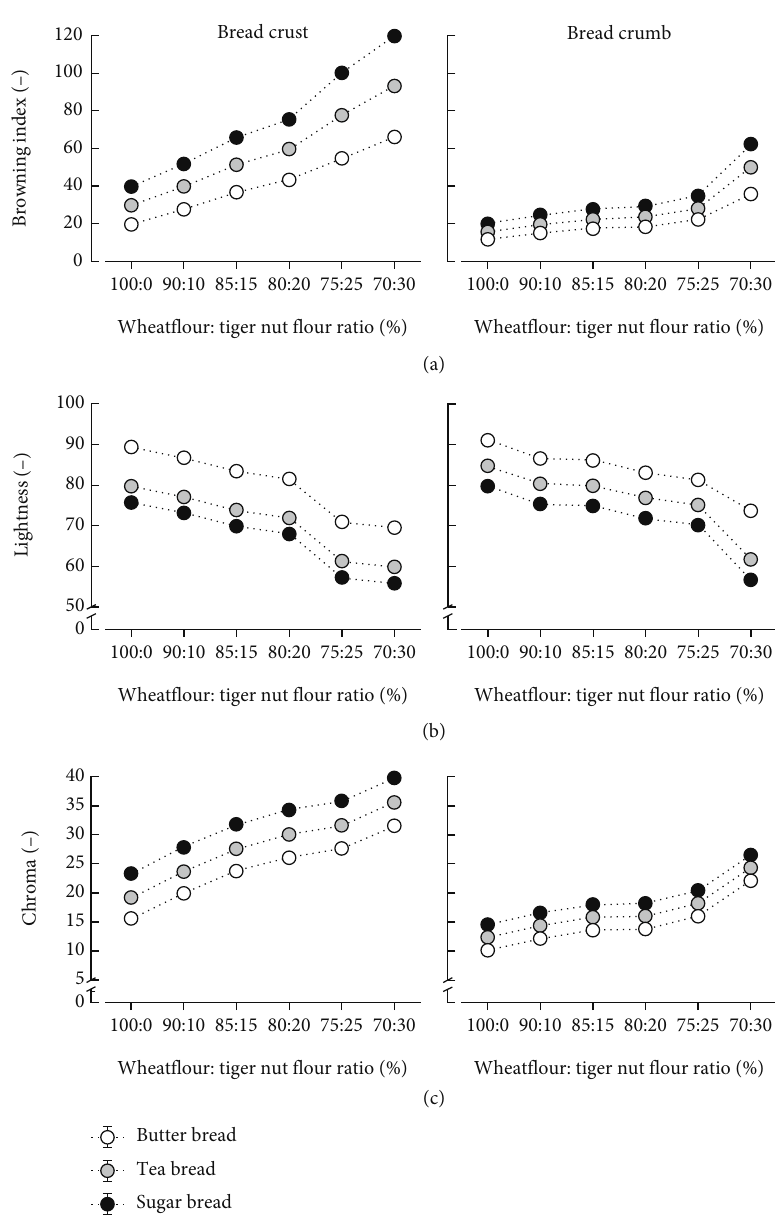
Figure 2: E ff ects of substituting wheat fl our with tiger nut fl our on browning index (a), lightness (b), and on Chroma (c) of the crust and crumb of butter bread, tea bread, and sugar